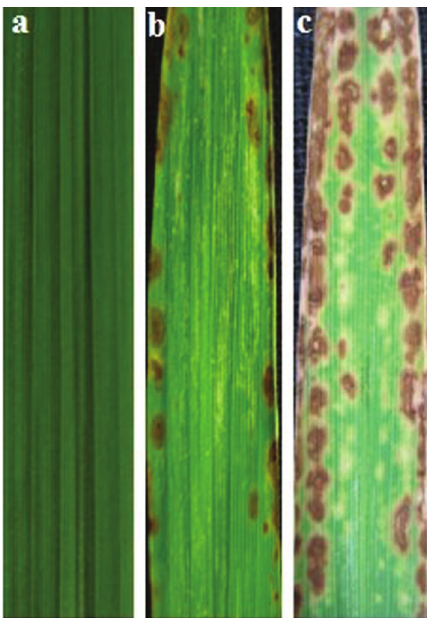
Figure 1 - Phenotype of wild-type and mutant leaves. (a) Leaves of wild-typeplantgrowninthefield,(b)Leavesof spl30 mutantgrowninthe field and (c) Leaves of spl30 mutant grown in a